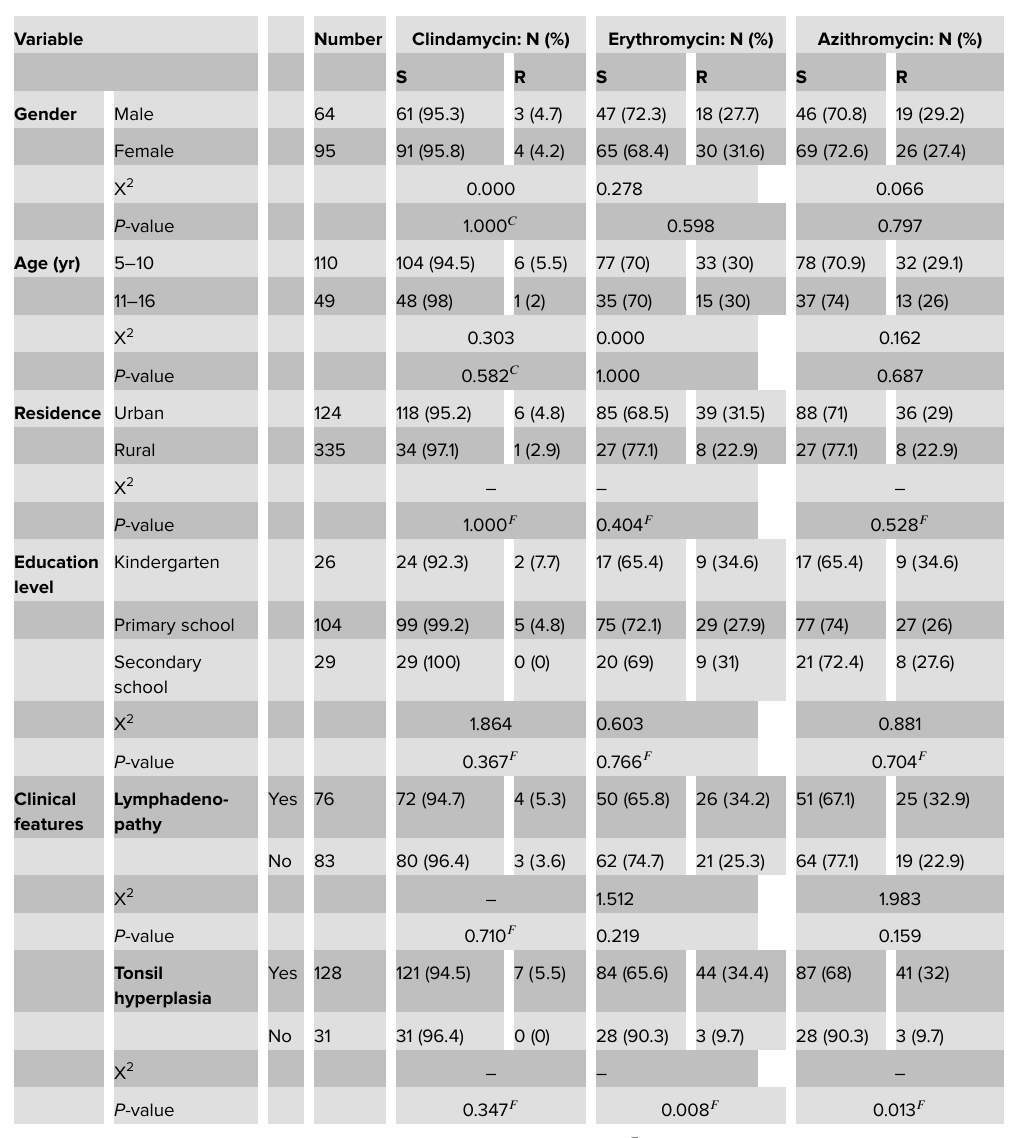
Table 4: Relationship of antibiotics susceptibility patterns of the GAS isolates (N = 159) with gender, age groups, residence, and clinical features of study